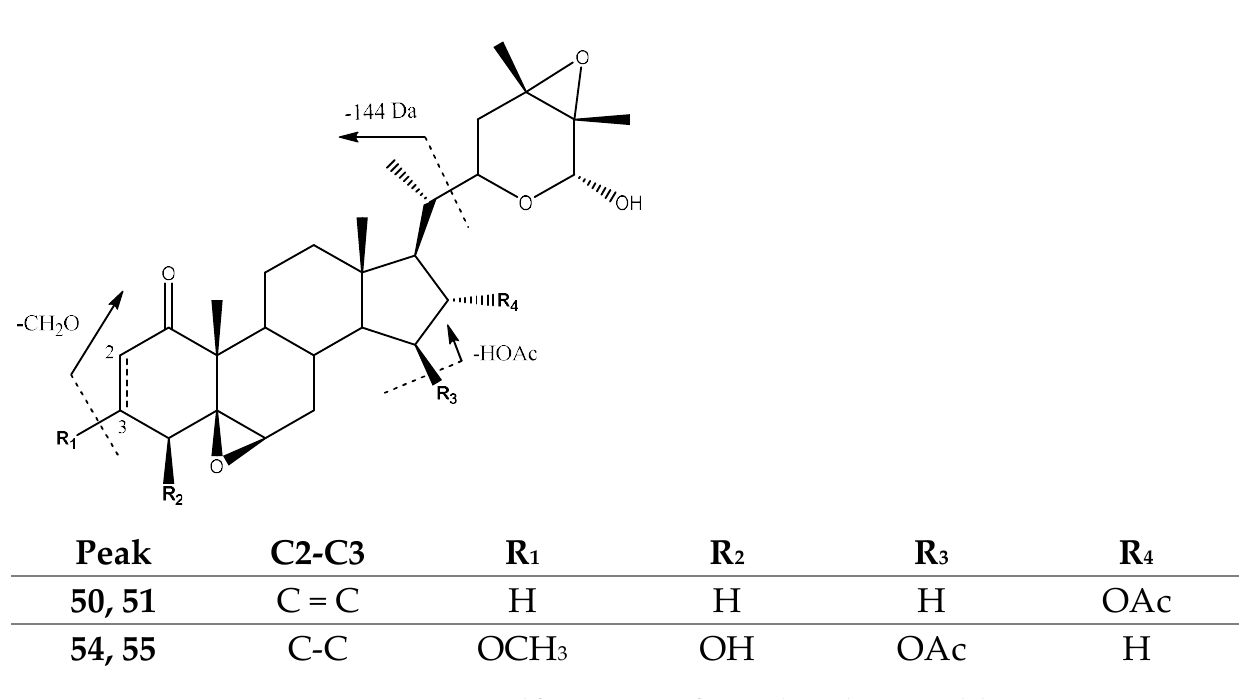
Figure 6. Structure and fragmentation of Virginol C and Peruvianolide E isomers.